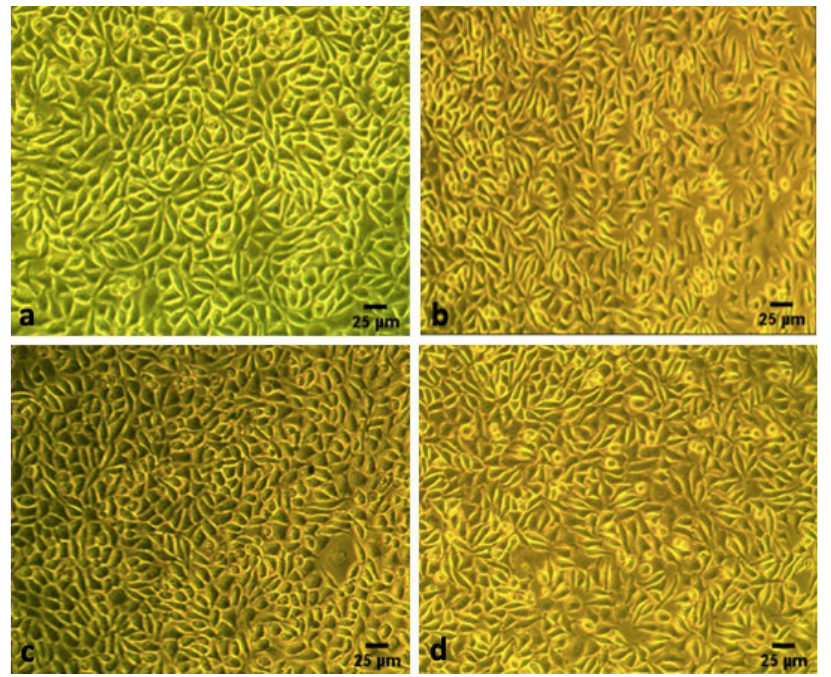
Figure 3 . The morphological views of cells. Control Groups: ( a ) The medium control group, ( b ) The medium-free control group, ( c ) The physical control group, and ( d ) The light applied control group. The scale bar in each image equals to 25 μm.